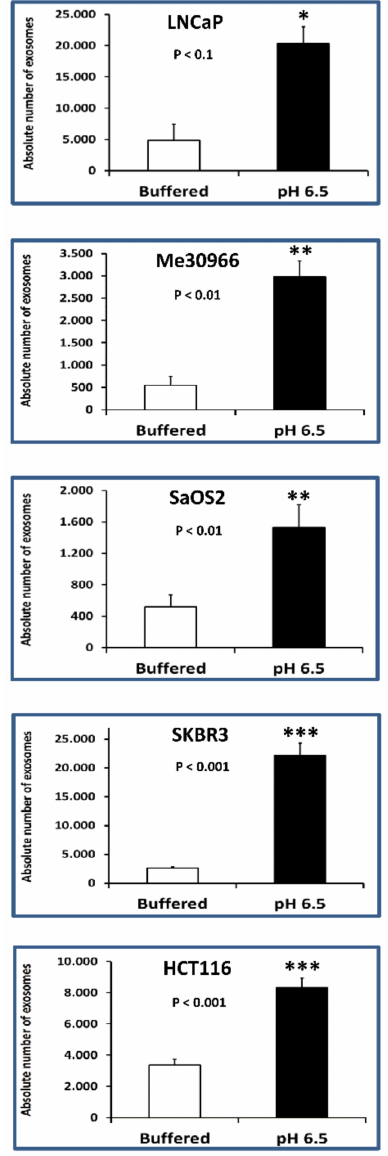
Figure 3. Nanoscale flow cytometry of exosomes in tumor cells cultured in buffered and pH 6.5 conditions. The cytometer was calibrated using a mixture of non-fluorescent silica beads and fluorescent (green) latex beads with sizes from 110 nm to 1300 nm. The exosome preparation derived from several tumor cell line (LNCaP, Me30966, SaOS2, SKBR3, and HCT116) supernatants cultured in different pH cell culture conditions (buffered and pH 6.5 medium) were stained with anti-CD9 and anti-CD81 antibodies and analyzed using flow cytometry. The double-positive events were then analyzed for their size, based on the calibration with beads. Cumulative data are shown of the absolute number of CD9 + /CD81 + exosomes of size less than 180 nm recovered from the samples at pH 6.5 as a function of those recovered from samples at pH 7.4. Data are expressed as means ± SE of three independent experiments. The p -values were <0.1 in all cellular lines cultured in pH 6.5 with respect to buffered conditions. * p < 0.1, ** p < 0.01, *** p <